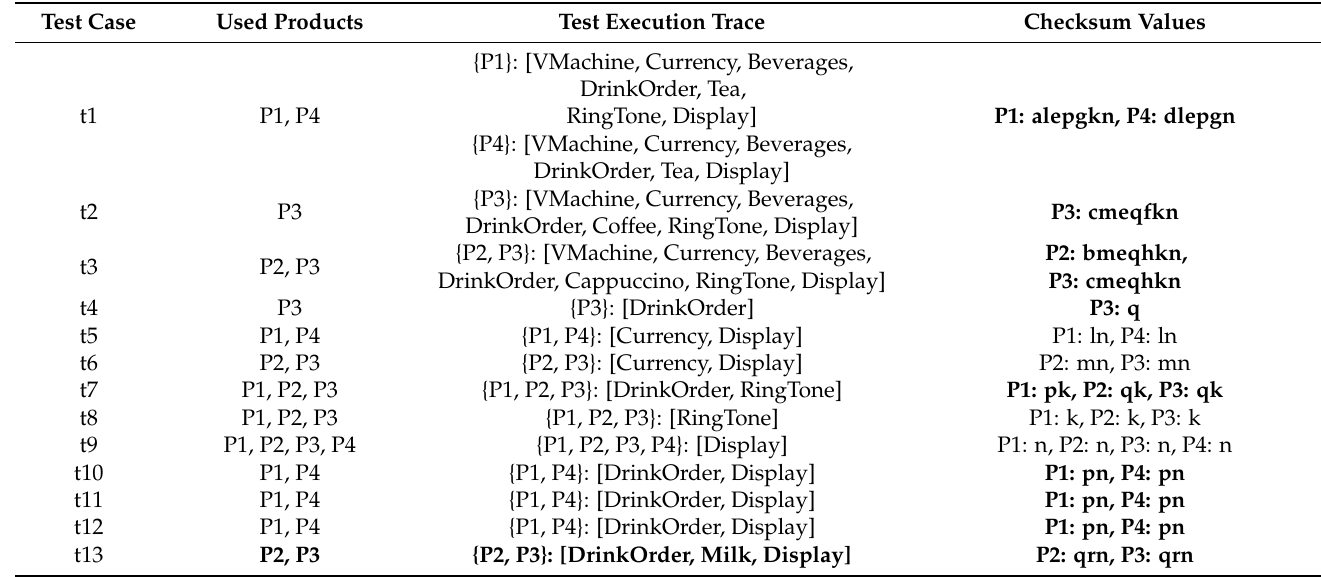
Table 13. Execution traces of test cases and their checksum values for SPL V2 . Checksum values changed in SPL V1 are presented as bold